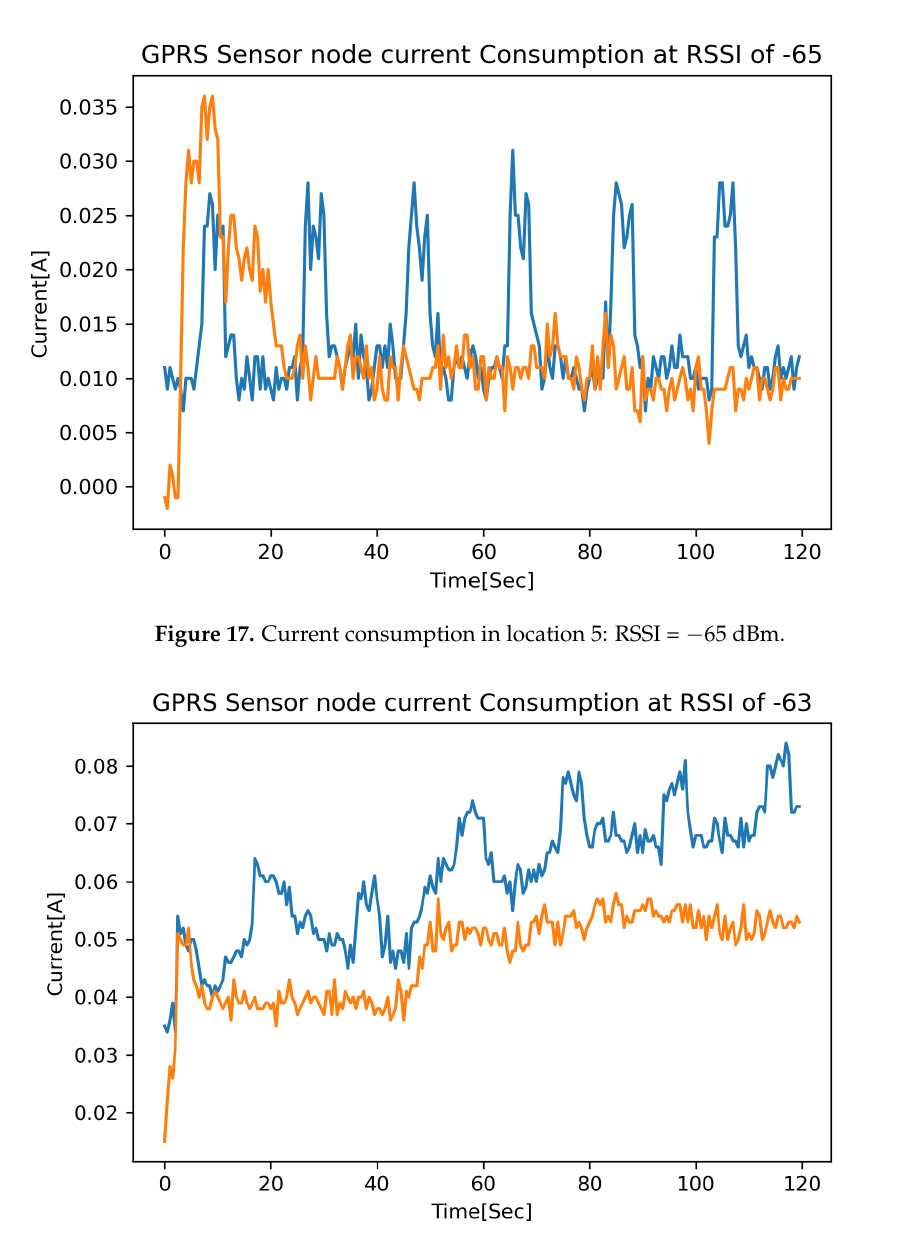
Figure 18. Current consumption in location 6: RSSI = − 63